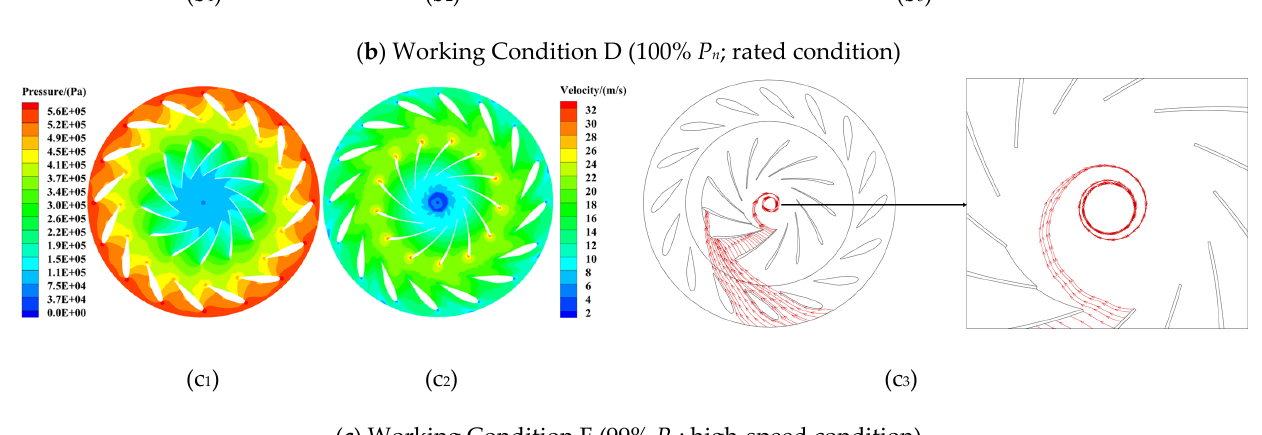
Figure 4. Meridian sections of distributor and runner. Note: ( a 1 – c 1 ) are pressure contours; ( a 2 – c 2 ) are velocity contours; and ( a 3 – c 3 ) are fluid streamline diagrams.